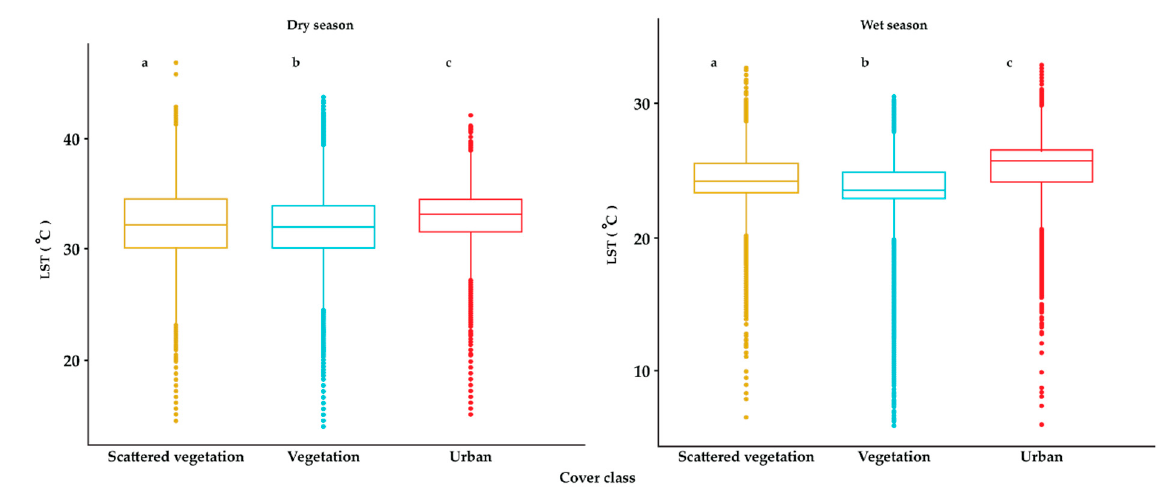
Figure 4. Land surfer temperature variation per classes of land cover in the dry season ( left ) and the wet season ( right ), different letters show statistically significant differences.